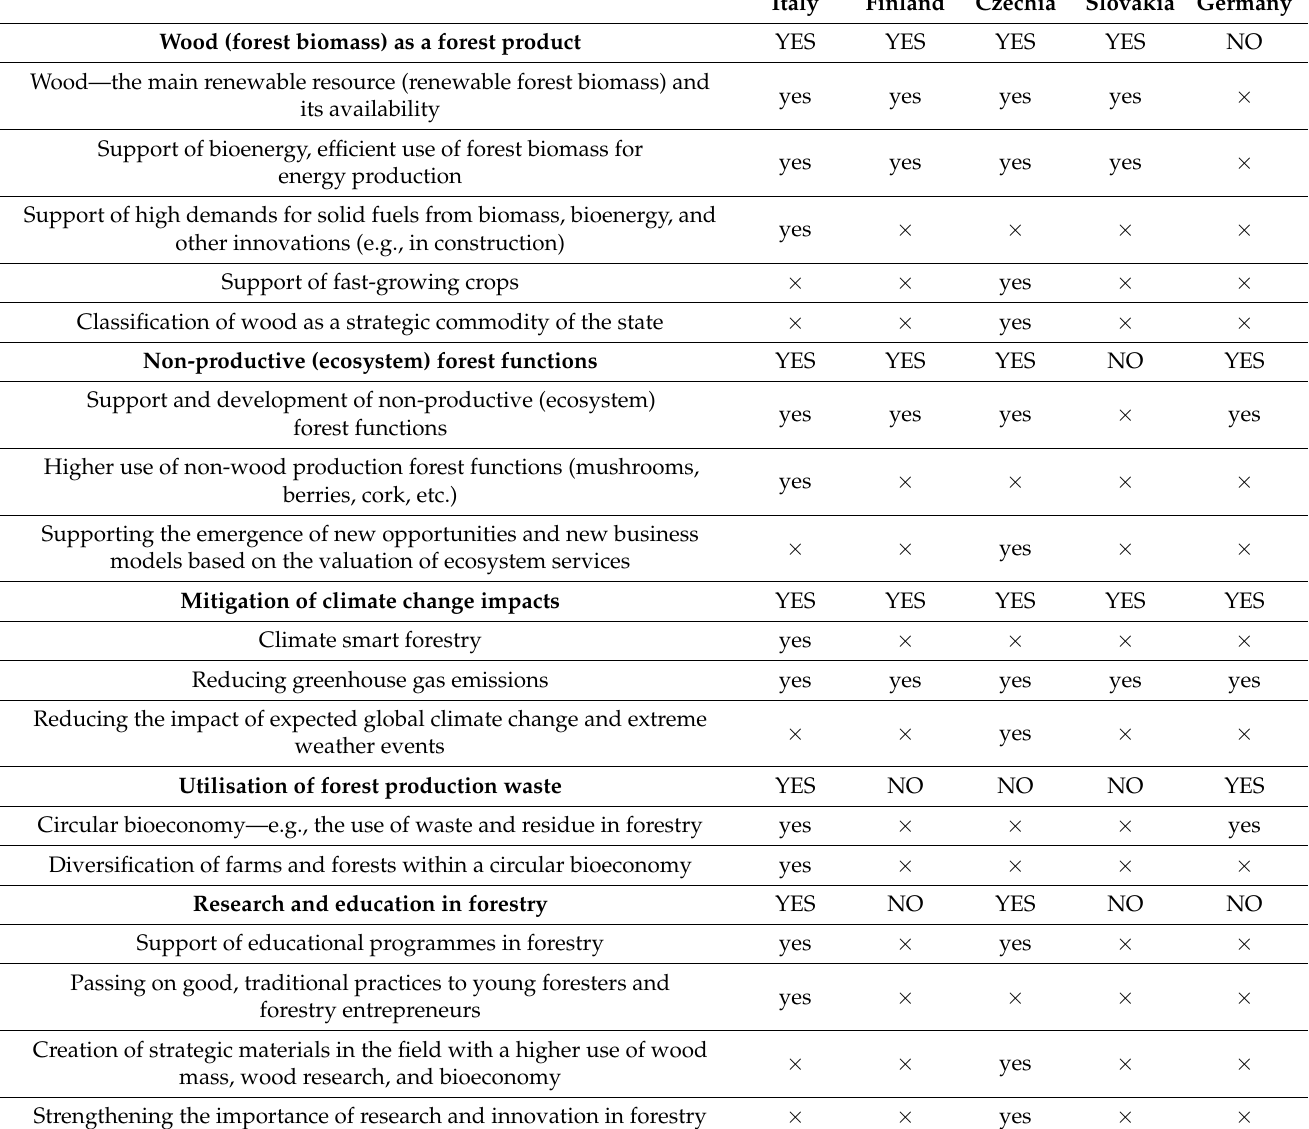
Table 2. Categories and subcategories of the FBE in the selected